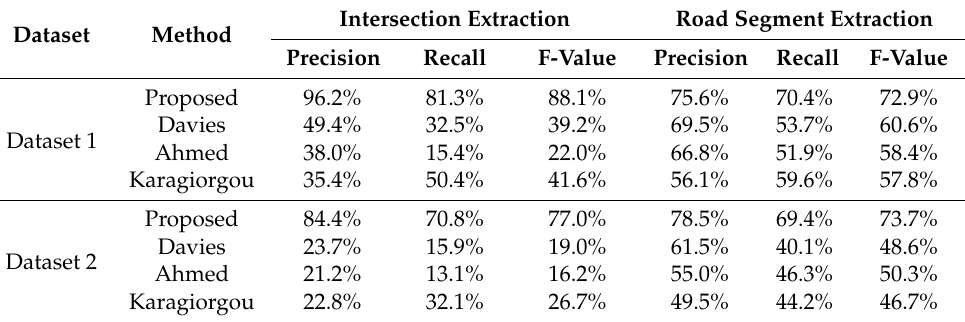
Figure 11. Quantitative comparisons of intersection extraction. ( a – c ) Wuhan dataset 1; ( d – f ) Wuhan dataset 2. Table 2. Comparison of experimental